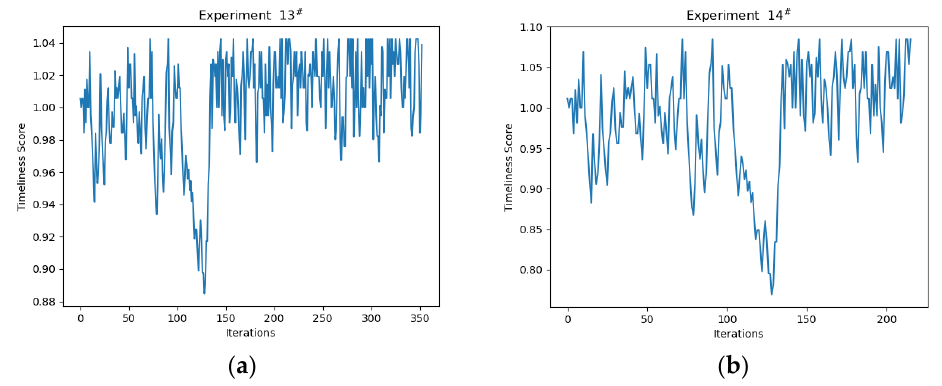
Figure 7. The fluctuation amplitude of timeliness score is different under the two parameters.